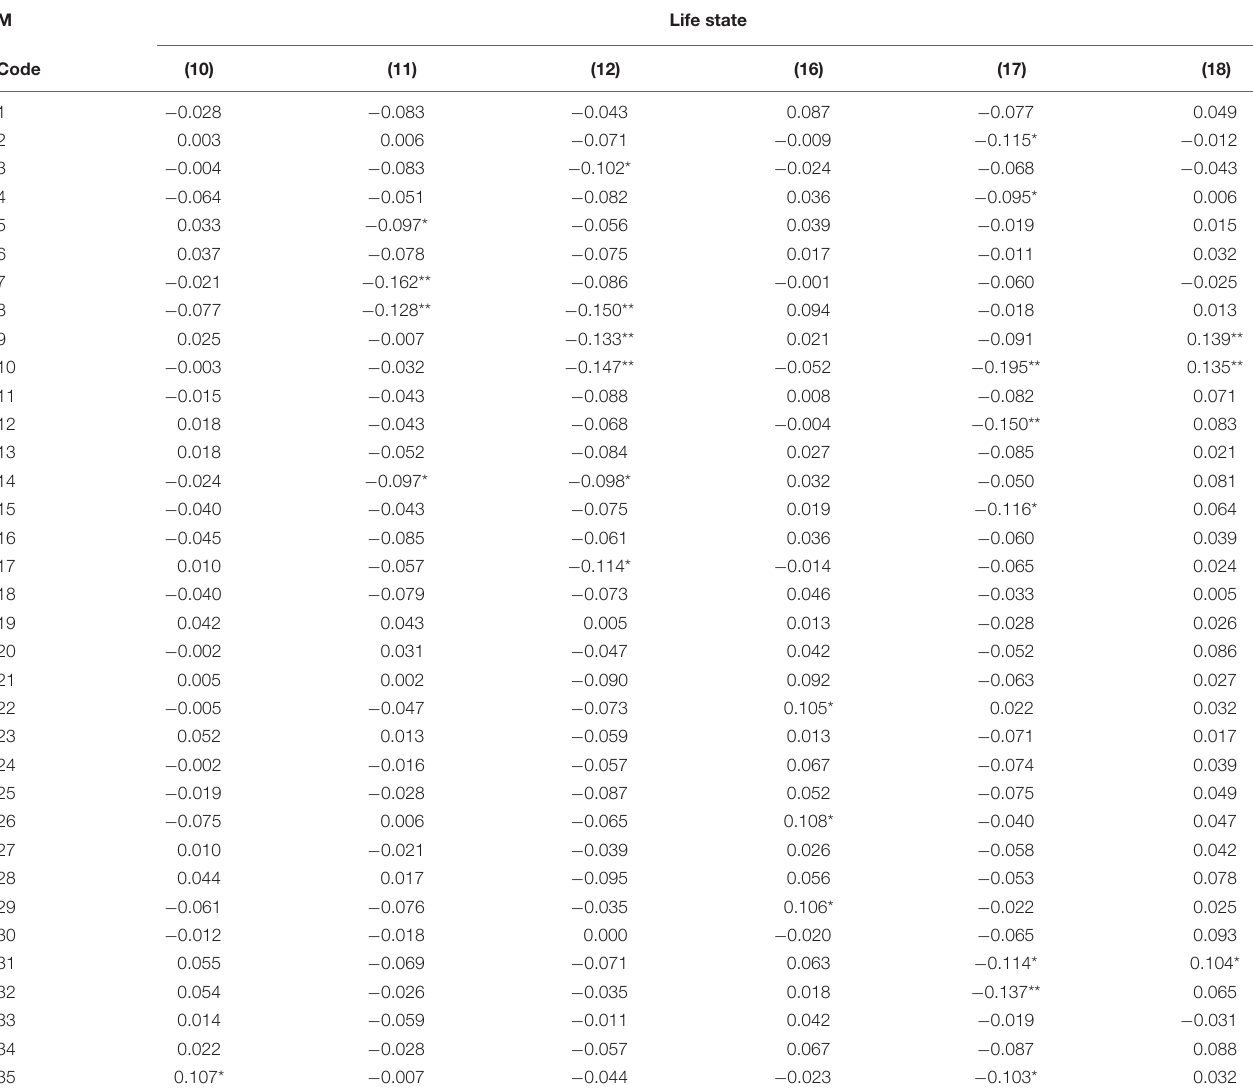
TABLE 5 | Correlation between life state and soundscape preference in the post − (code is shown in Table 1 ). M Life